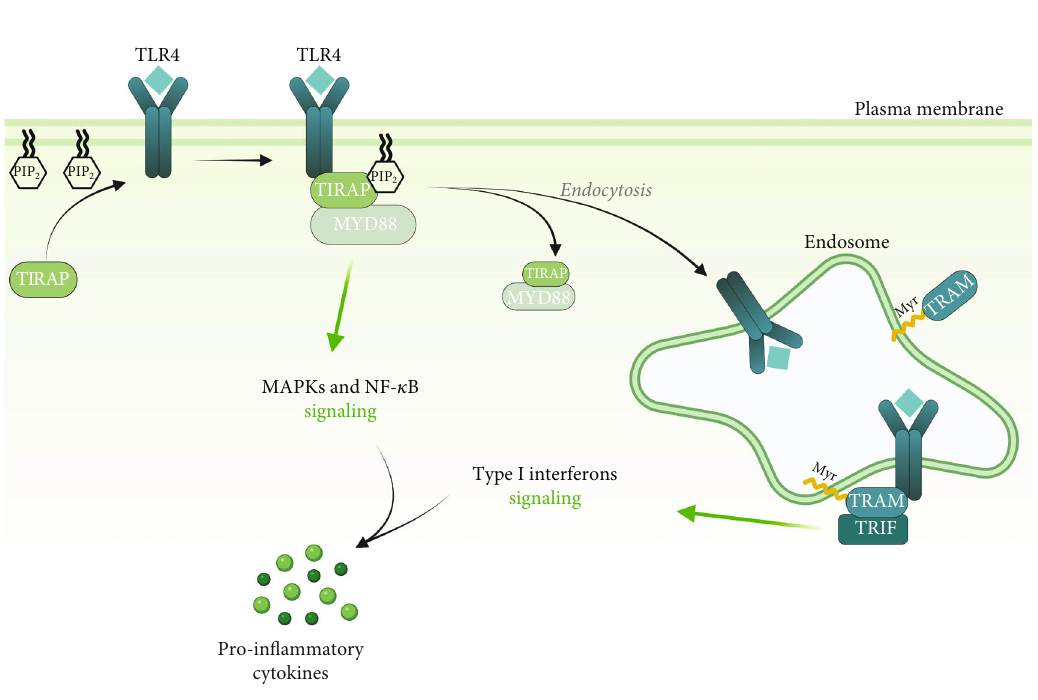
Figure 3: Schematic representation of the adaptors that bind the TIR domain of TLRs. TIRAP is preferentially localized at the cytoplasmic -binding domain and recruits MyD88. Myristoylated TRAM localizes at the endosomes and triggers IFN I membrane through a PIP 2 production via TRIF. Abbreviations: MAPKs: mitogen-activated protein kinases; MyD88: myeloid di ff erentiation primary response 88; : phosphatidylinositol bisphosphate; TIRAP: Toll/interleukin-1 receptor domain-containing adaptor NF- κ B: nuclear factor- κ B; PIP 2 protein; TLR: Toll-like receptor; TRAM: TRIF-related adaptor molecule; TRIF: TIR domain-containing adaptor-inducing interferon- β .